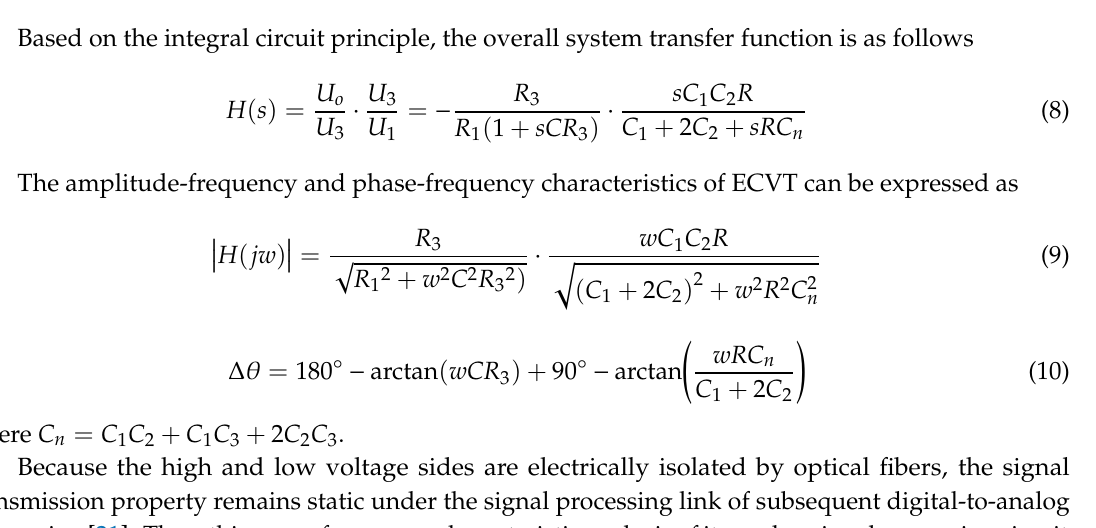
Figure 4. The equivalent circuit of primary voltage sensor.